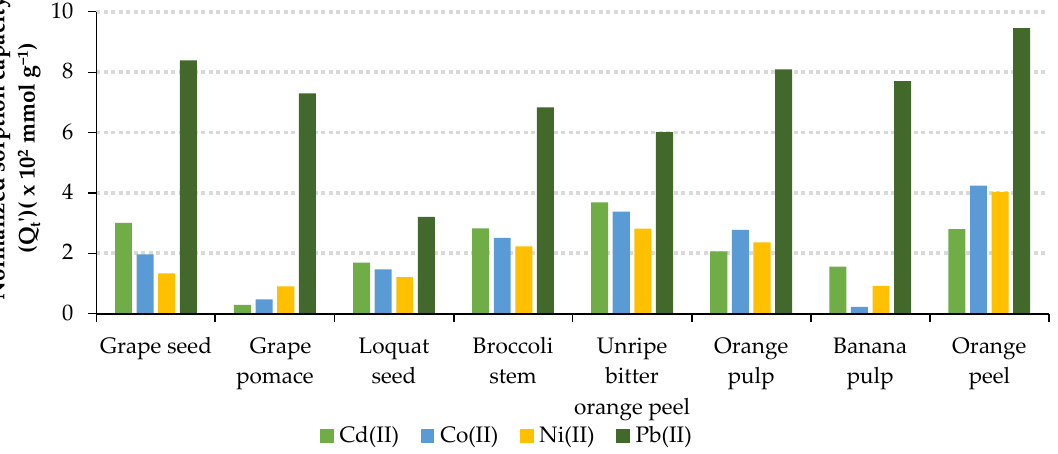
Figure 2. Normalized sorption capacity Q t ’ (mmol g − 1 ) of metal ions for biomasses with high and positive correlation: Group II.